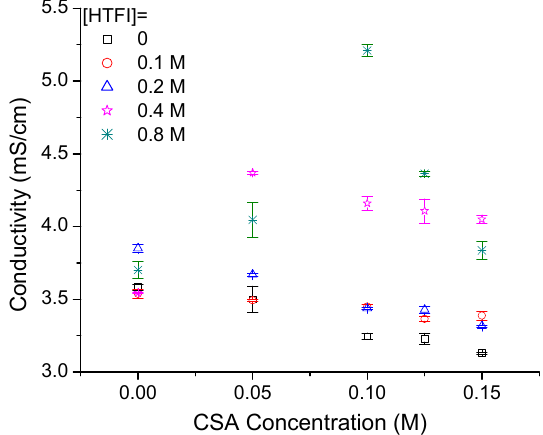
Figure 11. Conductivity of CSA solutions in HTFSI/BMIBF 4 .